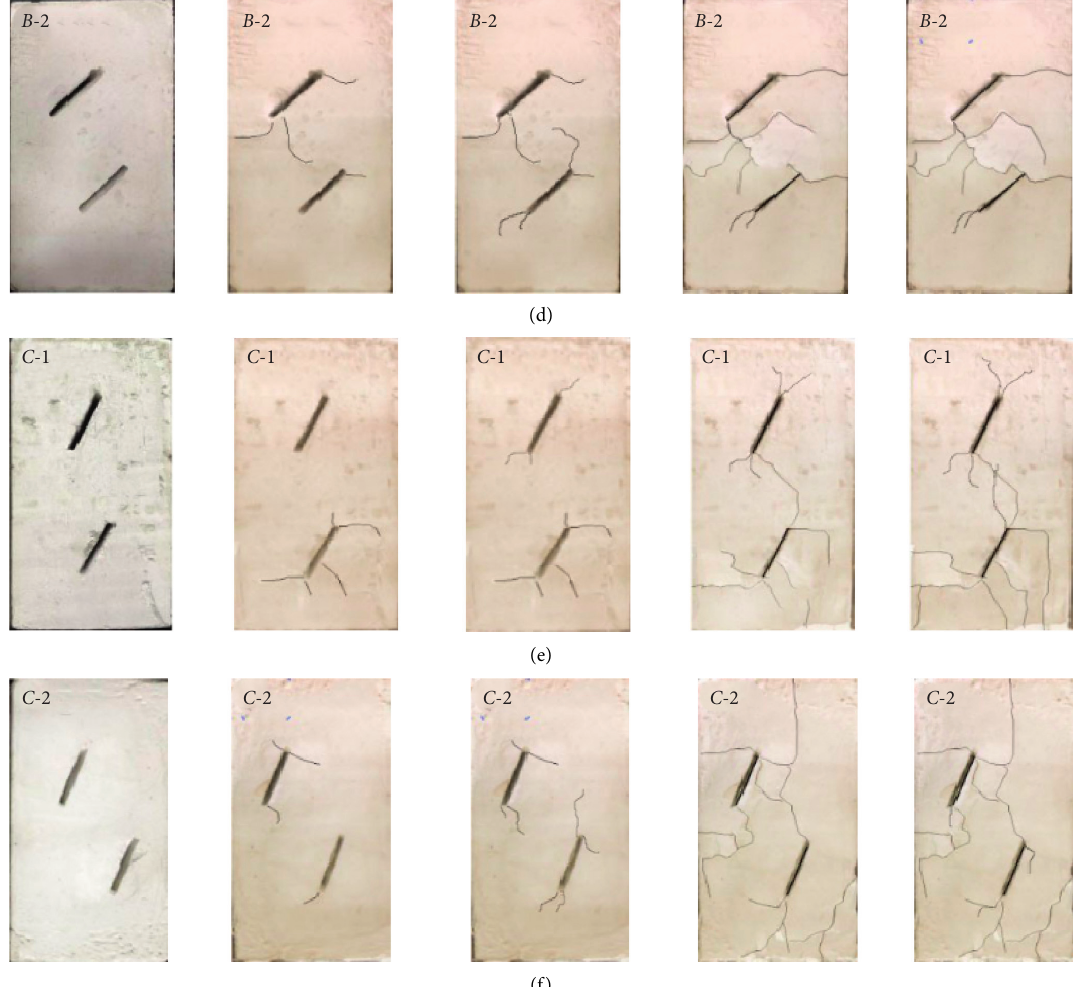
Figure 5: Major crack propagation during the specimen failure. (a) Fissure propagation on the specimen A -1. (b) Fissure propagation on the specimen A -2. (c) Fissure propagation on the specimen B -1. (d) Fissure propagation on the specimen B -2. (e) Fissure propagation on the specimen C -1. (f) Fissure propagation on the specimen C